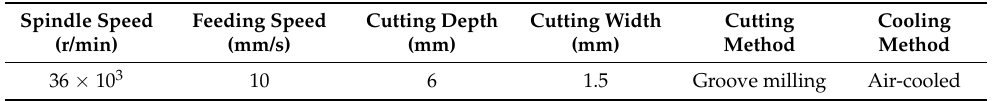
Table 4. Milling conditions of PCB milling